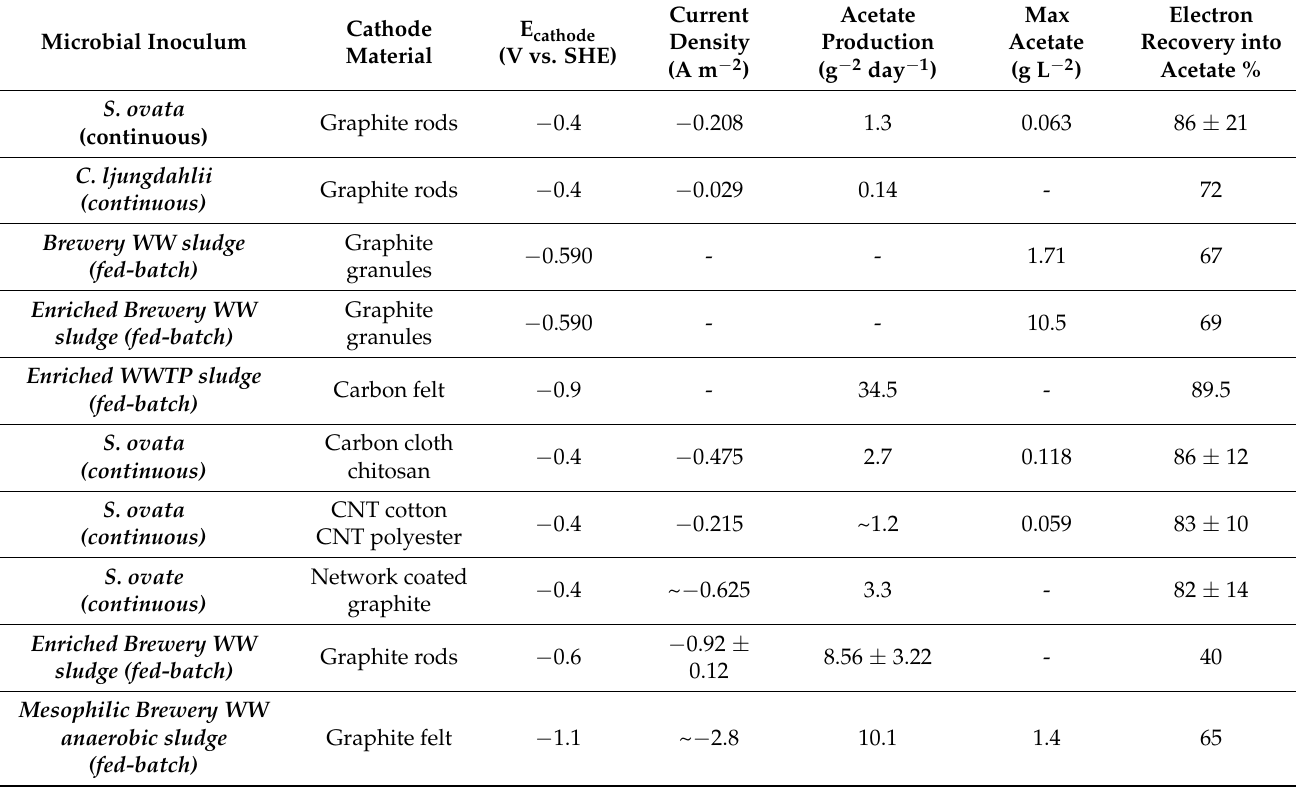
Table 5. Major performance factors of most MES to acetate researches reported until now. Adapted from [16,19,177,202]. Microbial Inoculum